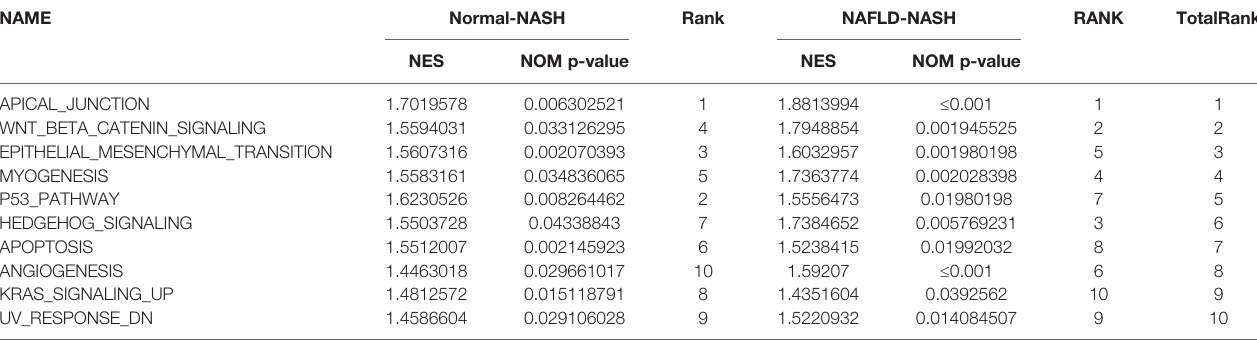
TABLE 2 | Intersected pathway between Normal-NASH group and NAFL-NASH group via GSEA analysis. NAME